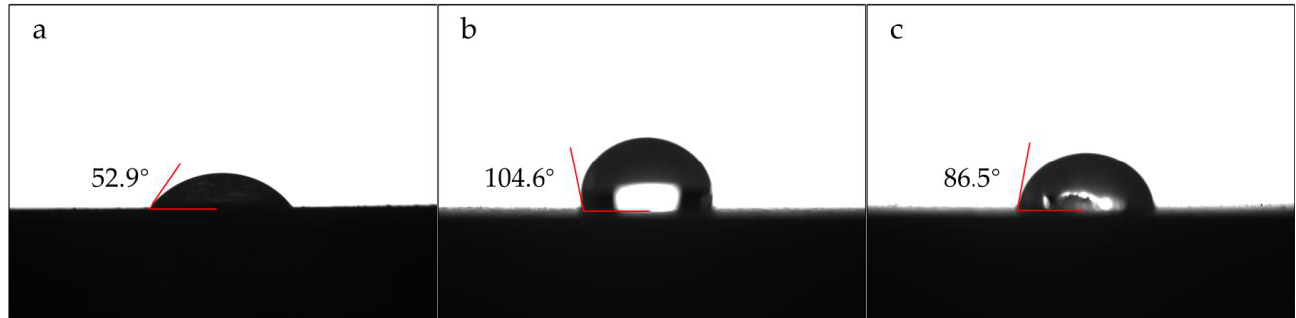
thaw resistance, as displayed in Figure 7b. Similarly, the film on H2 can improve the prop- erty to some extent. Figure 5. Chromatic aberration of H1 and H2 compared with DM. Figure 5. Chromatic aberration of H1 and H2 compared with DM.